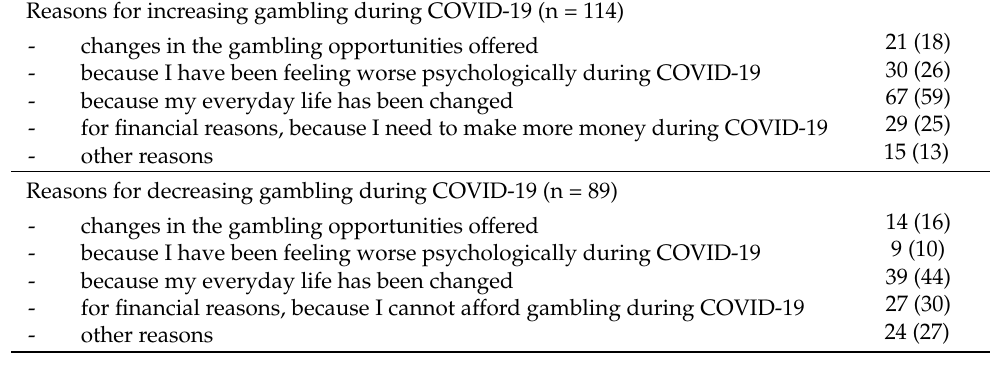
Table 5. Reasons for increasing (n = 114) or decreasing (n = 89) gambling during COVID-19. The two groups are mutually exclusive. More than one option can be selected, and therefore figures within each group do not sum up to 100%. n